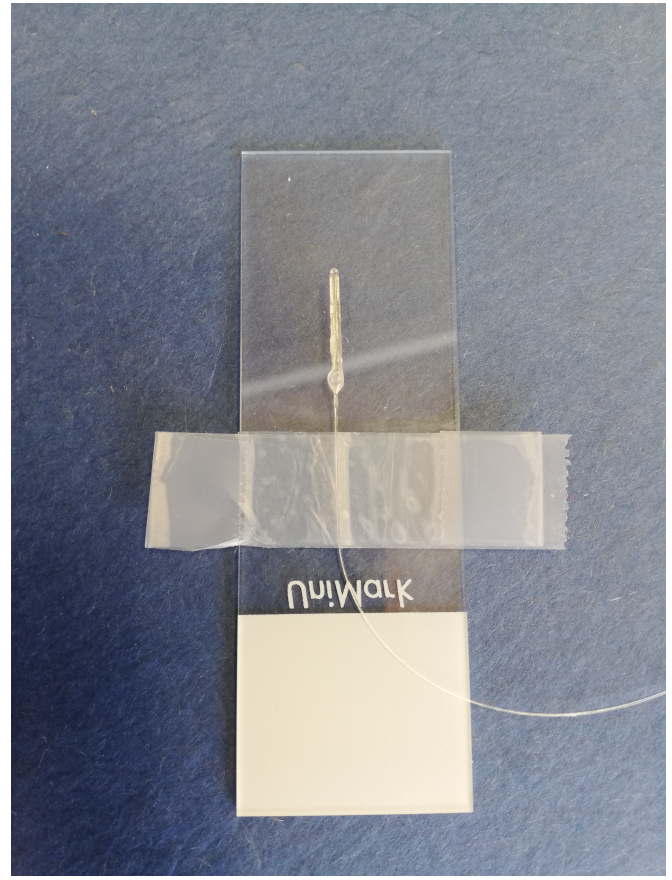
Figure 9. Finished UHRTS on a 75 × 26 mm microscope slide with SMF